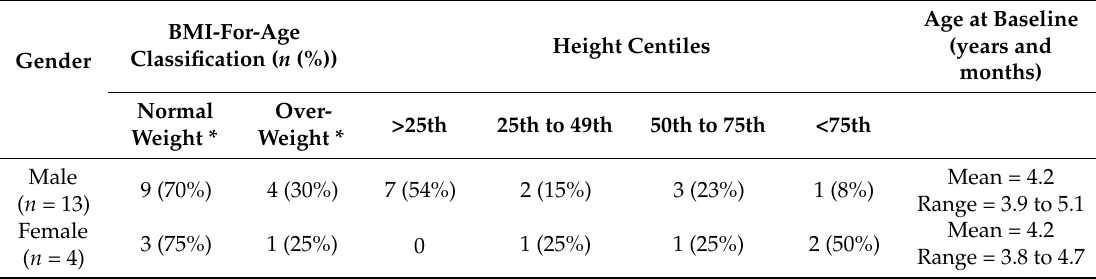
Table 1. Baseline demographics of the study participants.